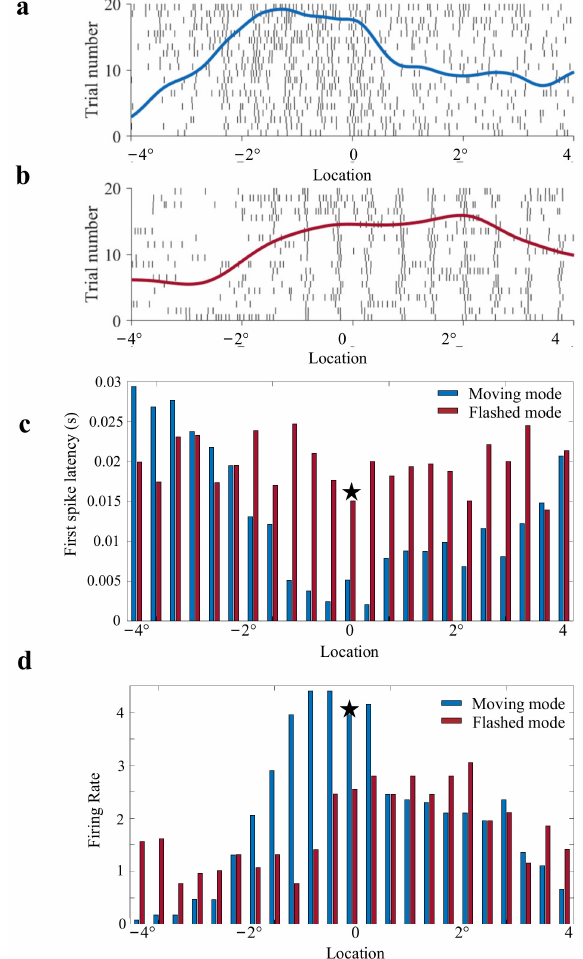
Figure 6. Responses to flashed and moving squares. ( a ) Raster plot showing neural responses to the moving stimuli, aligned to the stimulus onset time. The dot denotes a spike event and each row is a trial (only a subset of trials is shown). The blue line denotes the mean post-stimulus time histograms for 20 repetitions. ( b ) A raster plot and post-stimulus time histograms for the flashed stimulus. The responses were sorted by location sequence. ( c ) The histogram of the first spike latency to moving and flashed square stimuli at a location inside the receptive field for 20 repetitions. The blue histogram represents the response to a moving stimulus and the red histogram represents the response to a flashed stimulus. ( d ) The histogram of firing rates to moving and flashed square stimuli at a location inside the receptive field for 20 repetitions. The blue histogram represents the response to a moving stimulus and the red histogram represents the response to a flashed stimulus. Asterisk indicated a response to stimuli which crossed the receptive field